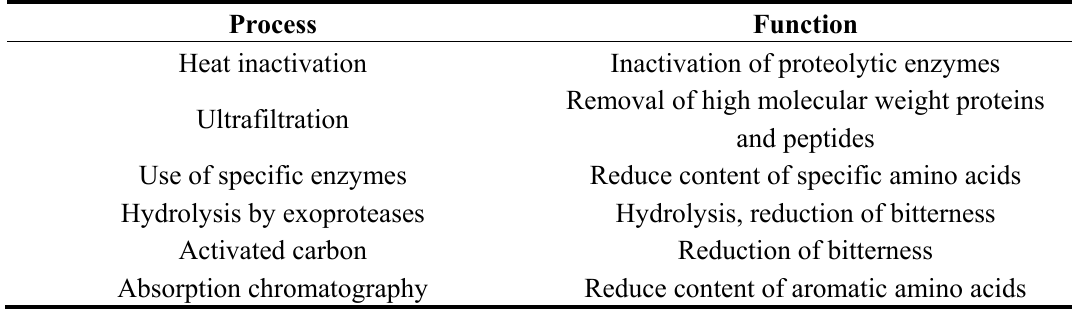
Table 1. The main processes used following hydrolysis of protein (post-hydrolysis